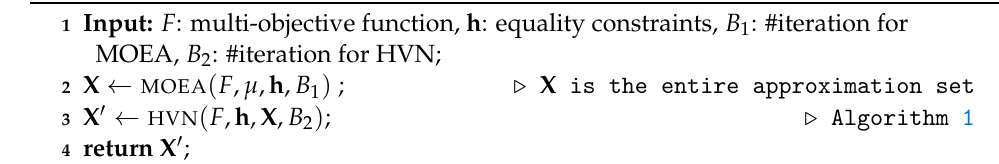
Algorithm 2: Hybridization of HVN and